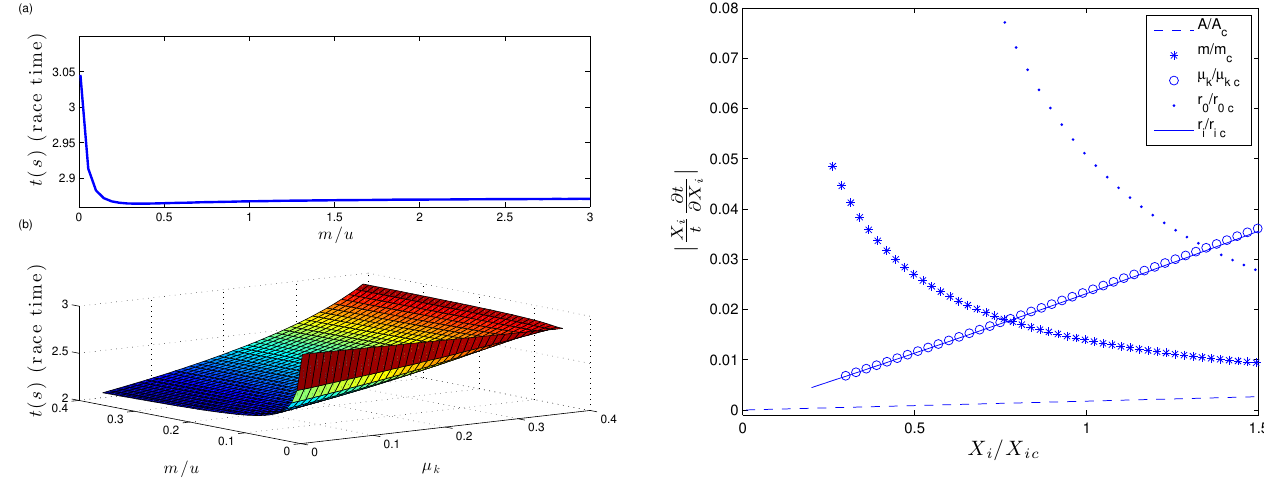
Figure 9. The race time of the car as a function of the car mass with parameters given in Table 2 and µ k = 0 . 35 (a) . The race time of the car as a function of both the car mass and the coe ffi cient friction µ k with parameters given in Table 2 and the normalization constants u = 0 . 1091Kg (b) .